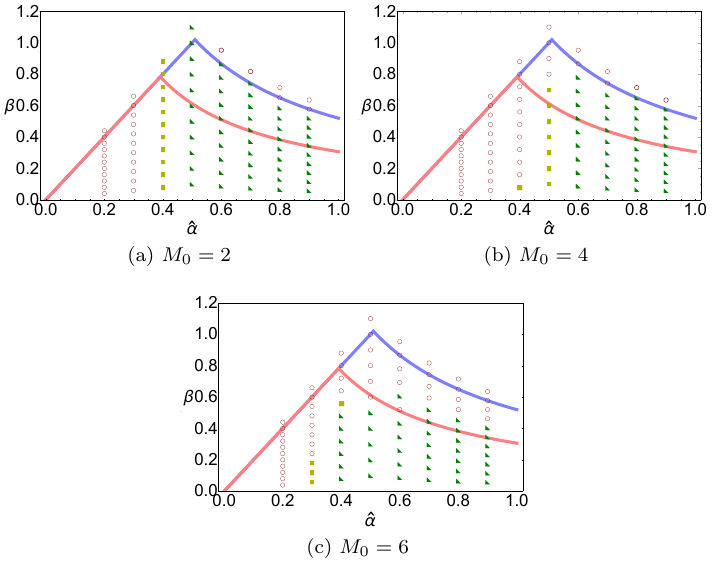
Figure 7. Practical stability analysis of the scheme B for β = 0 . 1 k (cid:98) β nec ( (cid:98) α,M 0 ), 1 ≤ k ≤ 11, in dependence on (cid:98) α , for M 0 = 2 , 4 , 6 and τ = (cid:98) αh/ ( | u | + c s